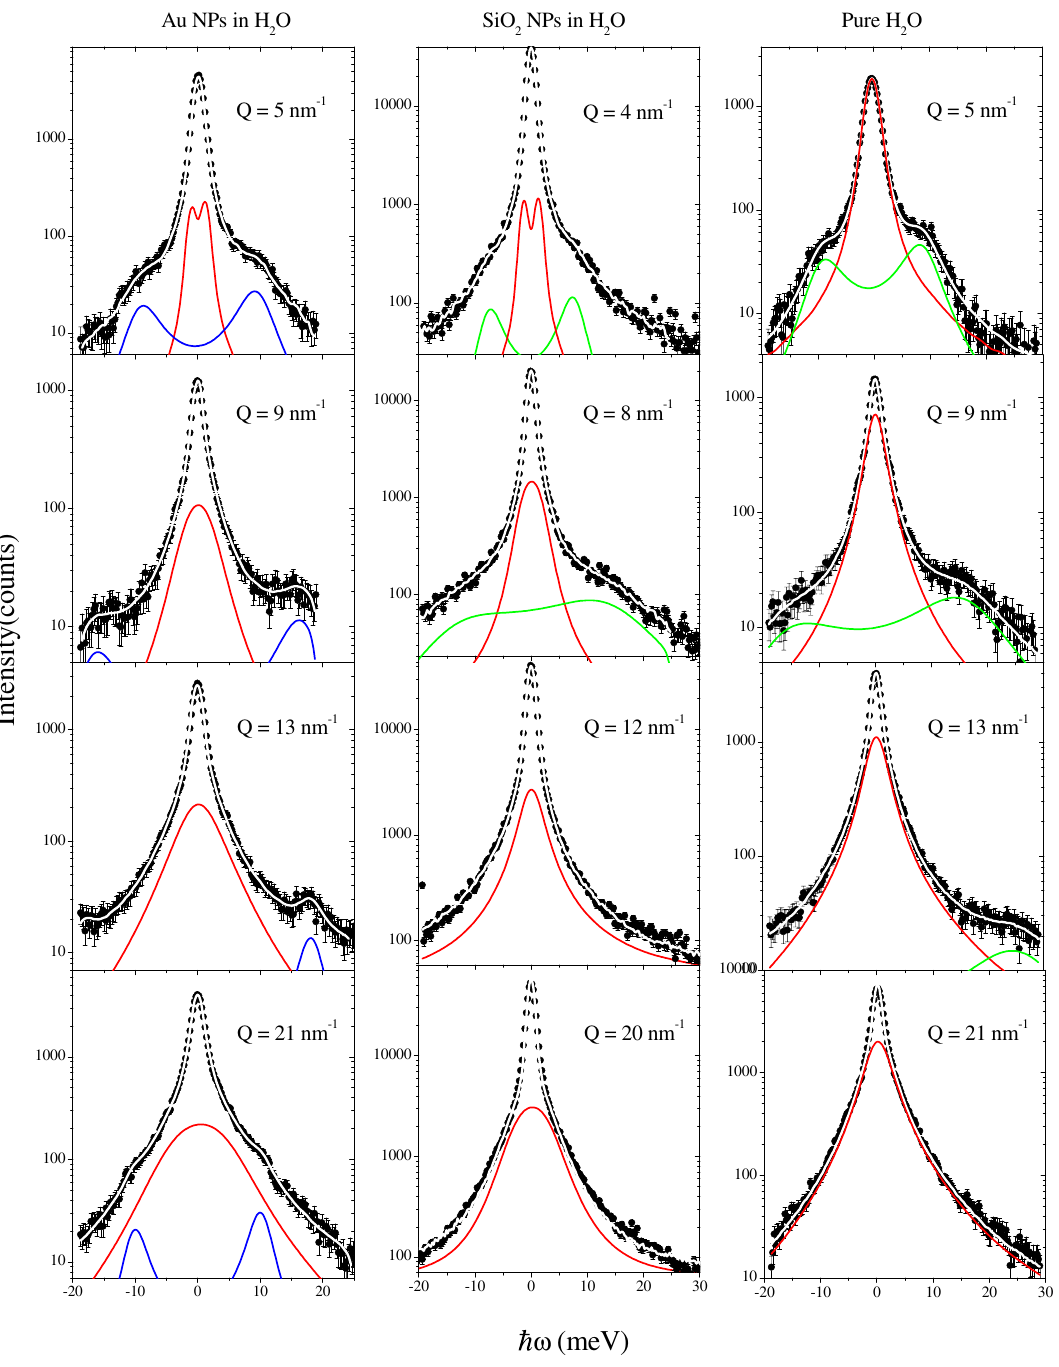
Figure 1. IXS spectra (open circles) of the (12 nm negatively charged) vSiO 2 -NP suspension in water measured at a few representative Q ’s and presented in this work (middle column) are compared with those we previously measured 24 on a diluted (0.5 % weight concentration) aqueous suspension of 15 nm Au-NP (left column) and on pure water (right column). The IXS experimental profiles are compared with corresponding best-fit lineshapes (white lines through data) along with their high-frequency (green line) and low-frequency (red line) DHO model components (see text). Blue lines in the left column plots are DHO contributions arising from phonons in the Au-NP interiors. Notice that, for clarity, elastic and quasi-elastic components of best-fitting lineshapes are not included in the graphs. All samples considered are at ambient